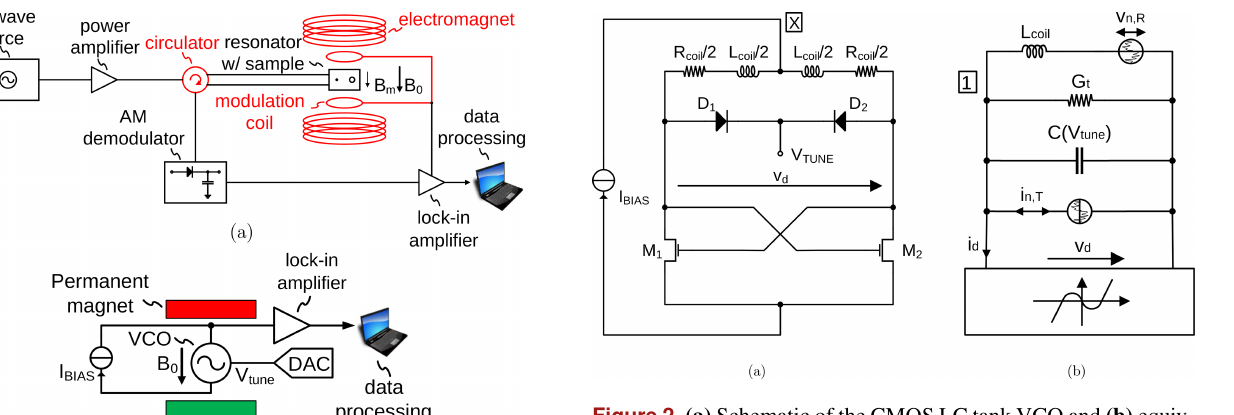
Figure 2. (a) Schematic of the CMOS LC tank VCO and (b) equiv- alent circuit modeling the current starved cross-coupled transistor pair as a static third-order